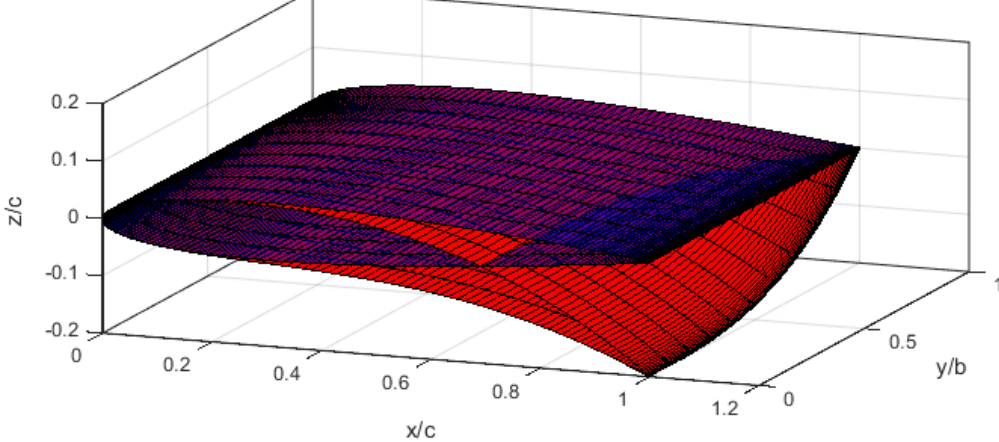
Figure 5. Representation of FishBAC spanwise and chordwise equations